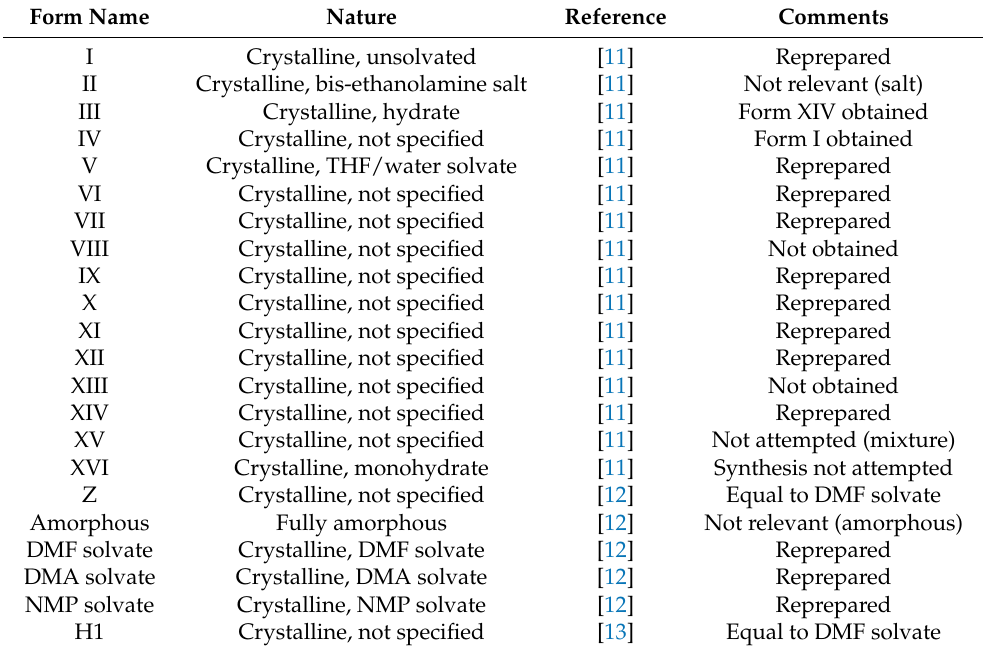
Table 1. Known Eltrombopag free acid polymorphs and solvates described in the